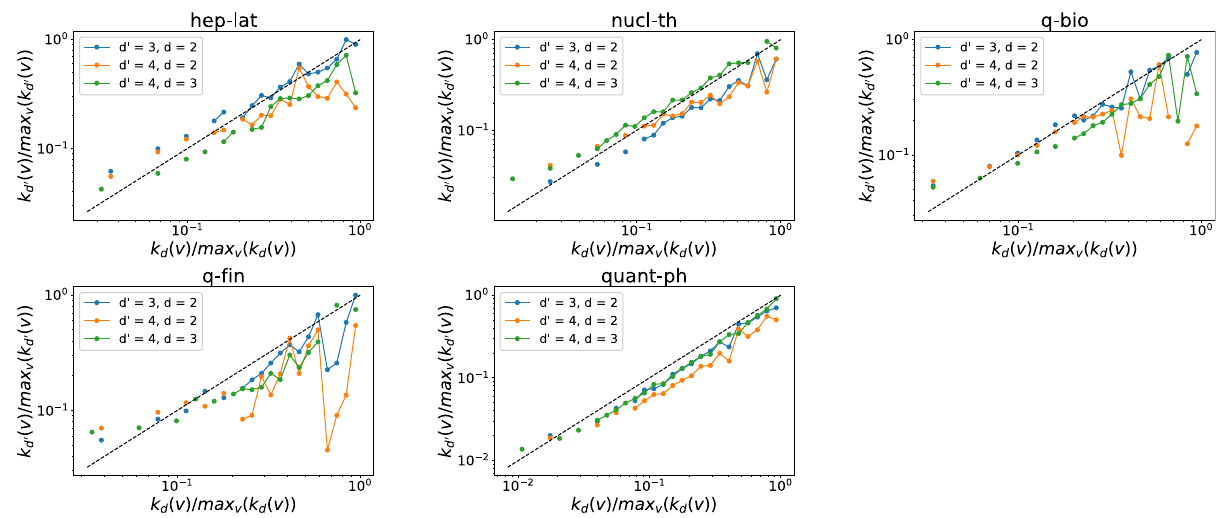
k d ′ ( v ) = k d ( v ) max v ( k d ′ ( v )) max v ( k d ( v )) . Note that both